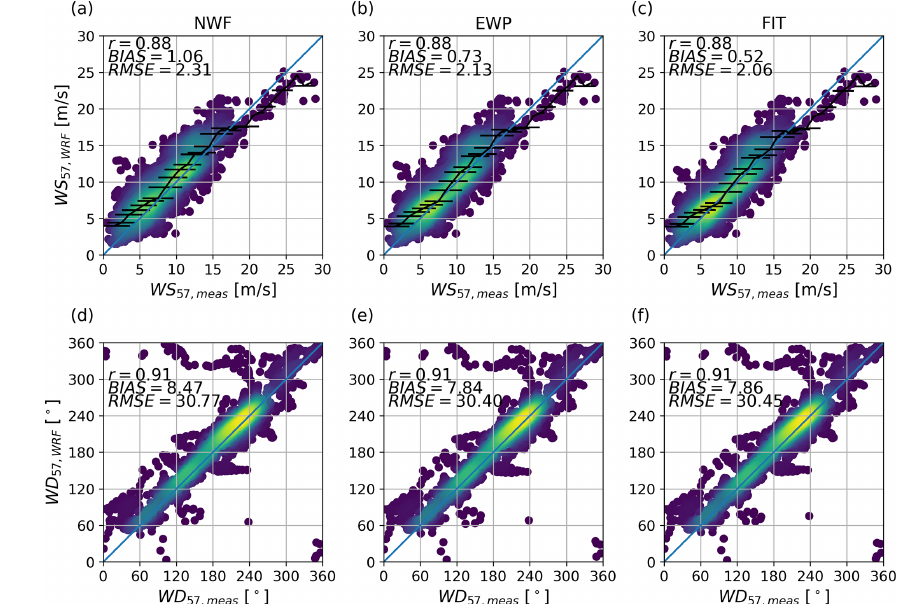
Figure 10. Scatter plot of measured (a–c) wind speed (WS) and (d–f) wind direction (WD) at 57m height against WRF simulations, namely (a, d) NWF, (b, e) NYRØ–EWP and (c, f) NYRØ–FIT (Table 7) for October